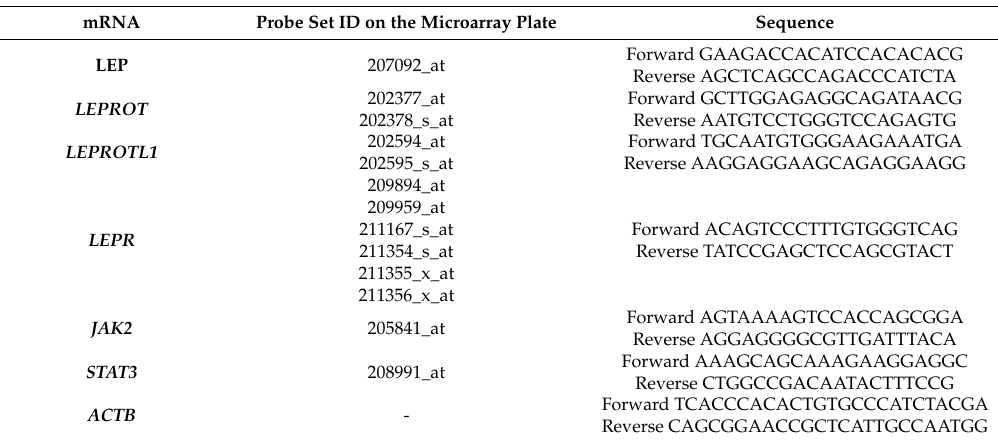
Table 4. Nucleotide sequence of primers used in the RTqPCR reaction and their Probe Set ID on the HG-U 133_A2 microarray